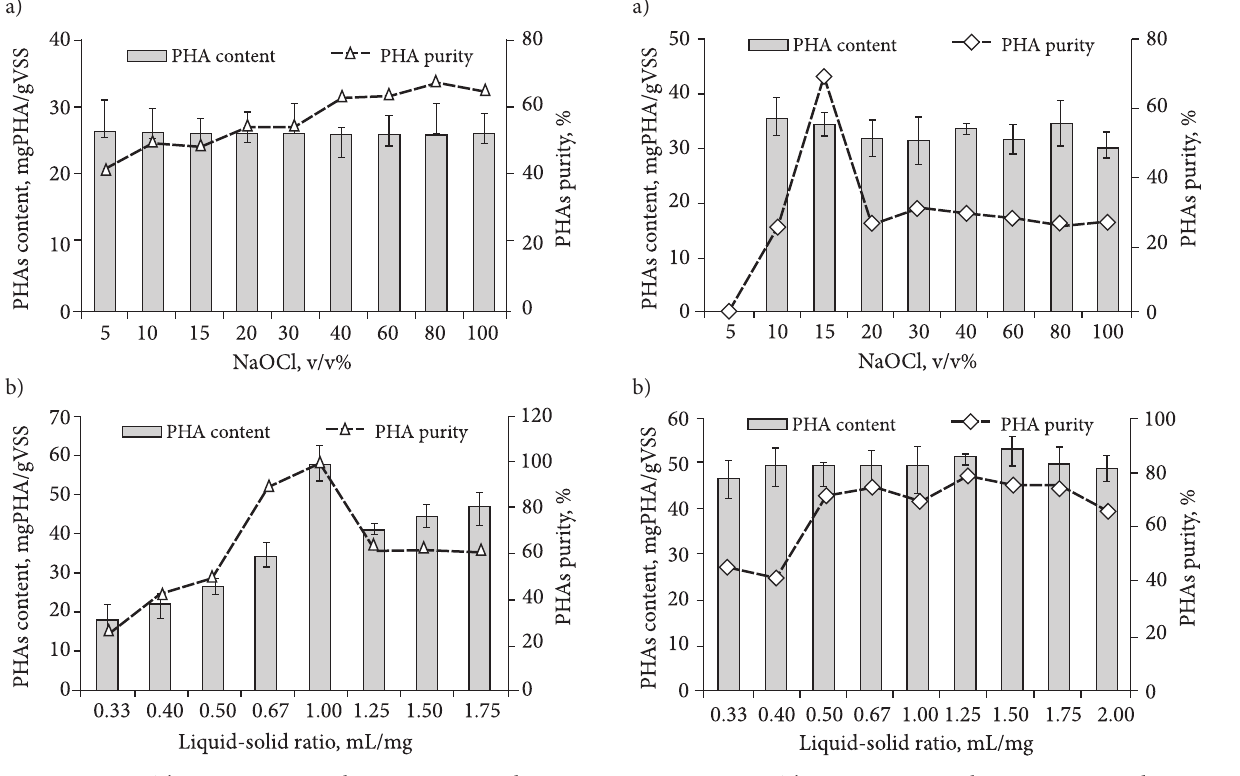
Figure 2. The optimum NaOCl concentration and L/S conditions for extracting PHAs from municipal wastewater